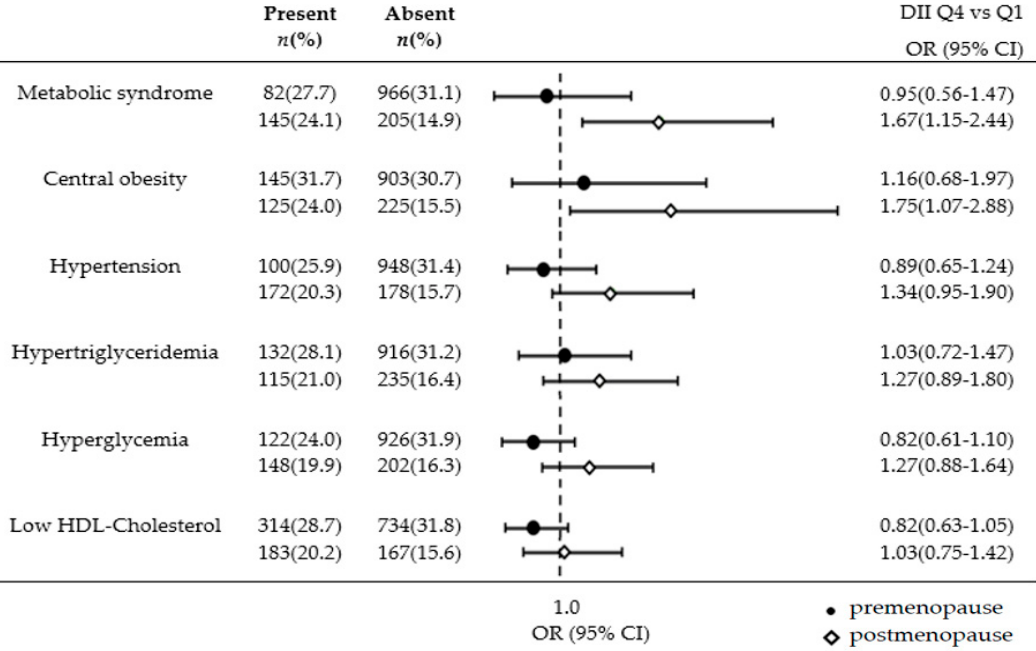
Figure 1. Odds ratio of metabolic syndrome risk factors by menopausal status of women by DII quartiles. DII: dietary inflammatory index; OR: odds ratio; CI: confidence interval. All analyses accounted for the complex sampling design and appropriate sampling weights of the national survey. Data were adjusted for age, BMI, education, alcohol consumption, smoking, physical activity, and total calorie intake.